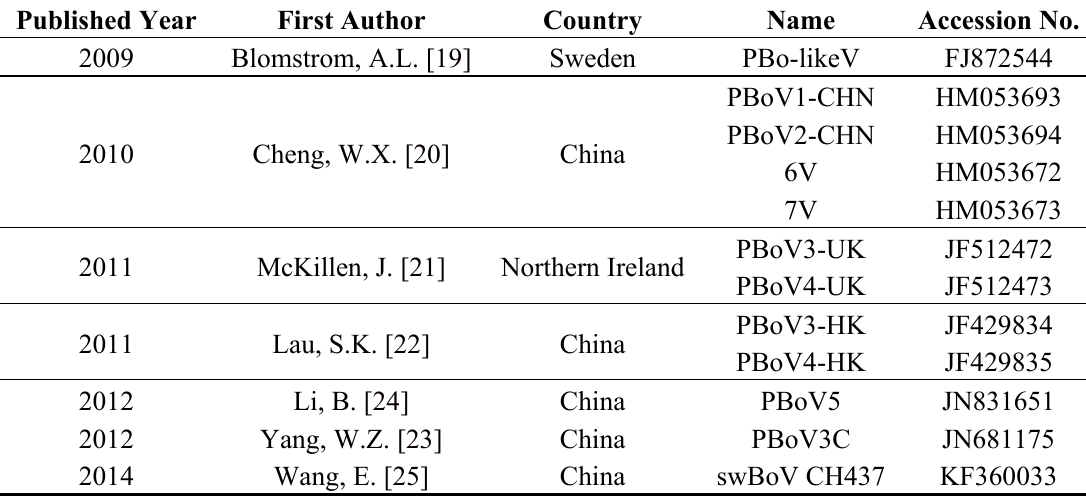
Table 1. Major studies that have reported porcine bocavirus discoveries.